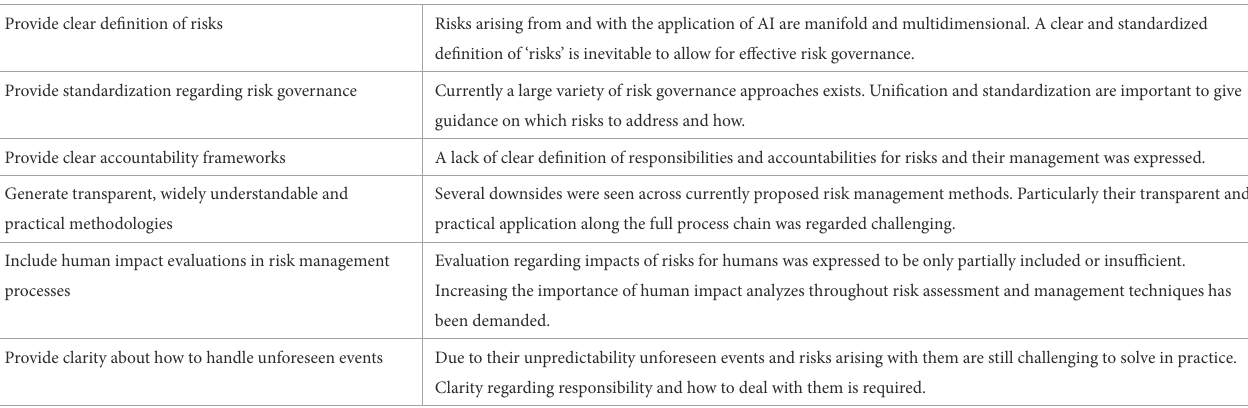
TABLE 2 Summary of “Call for Action”-items for regulators and organization derived from the workshop